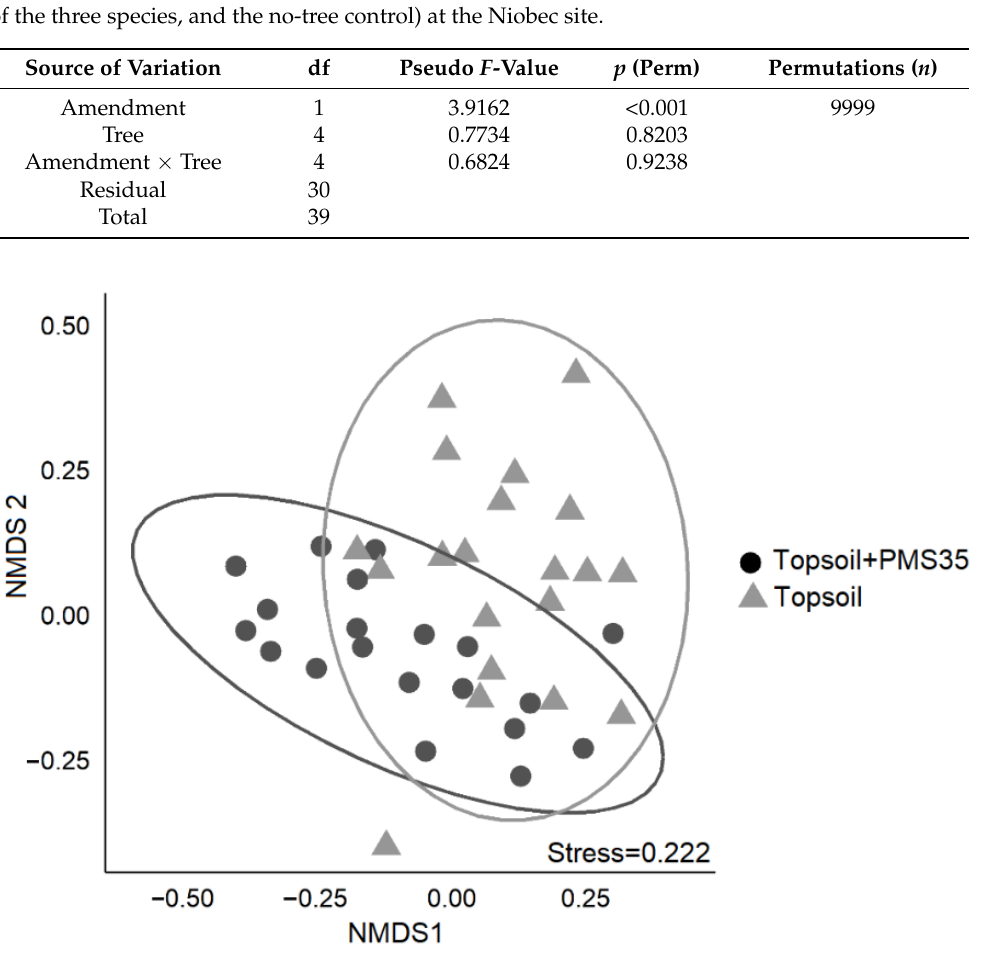
Table 4. Dissimilarity (%) of the species assemblages between amendment treatments (top ‐ soil+PMS35 and topsoil) at the Niobec site using SIMPER analysis of square ‐ root transformed data.